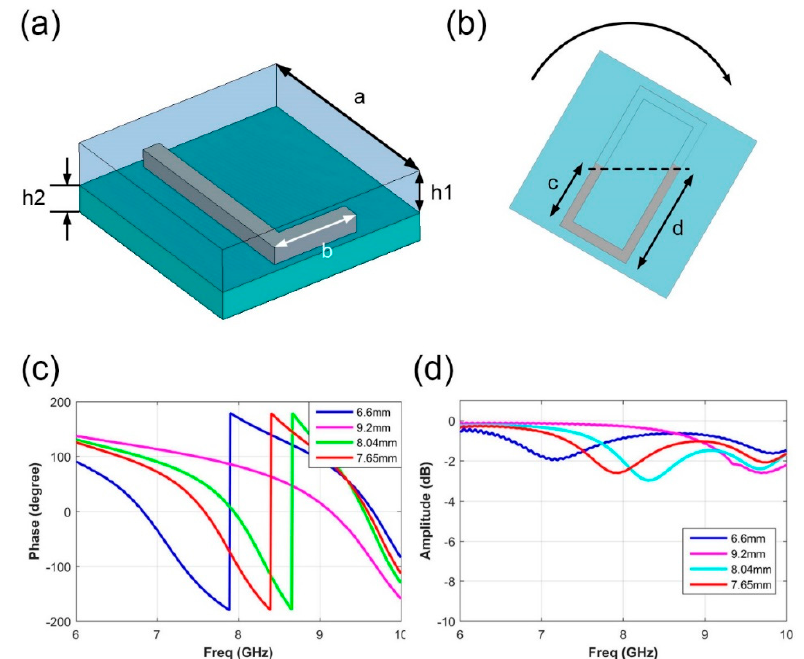
Figure 2. The element design and its simulation performance. ( a ) The detailed structure of the metasurface element. ( b ) The liquid-metal reconstruction by rotating the element. ( c ) The simulated results of reflection phase responses of four element dimensions, where d is 6.6 mm, 9.2 mm, 8.04 mm, 7.65 mm. ( d ) The simulated results of reflection amplitude responses of four element dimensions, where d is 6.6 mm, 9.2 mm, 8.04 mm, and 7.65 mm.